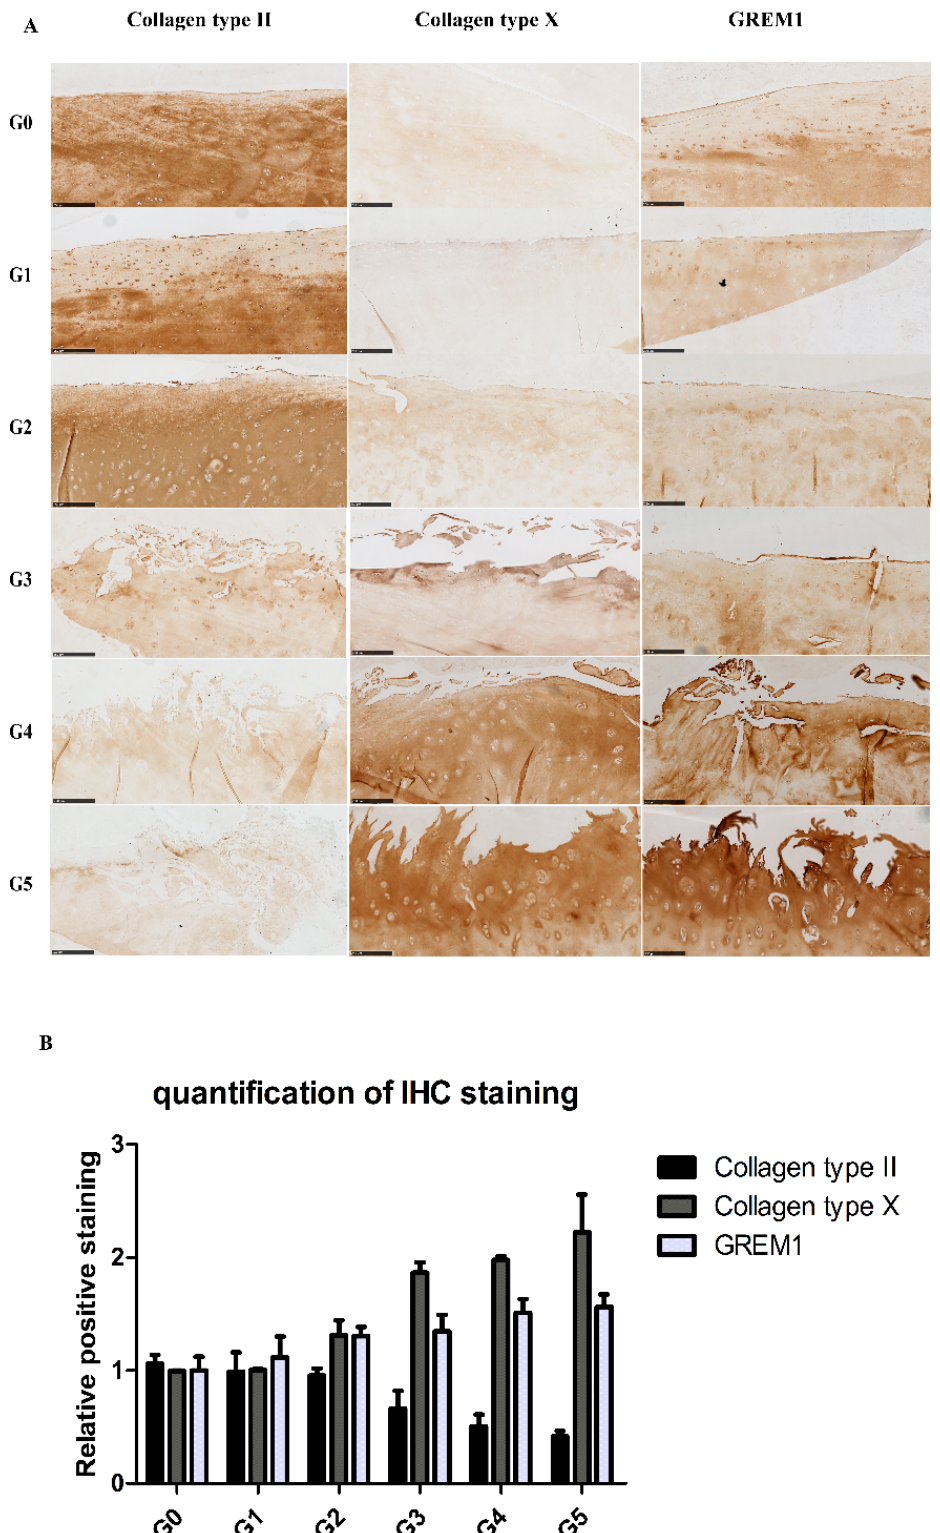
Figure 2. The protein expression of collagen type II, collagen type X and GREM1 was visualized by IHC (scale bar 250 µm). ( A ) Representative pictures are shown. Images were taken using the Nanozoomer. G0, G1, G2, G3, G4, G5 = Grade 0, Grade 1, Grade 2, Grade 3, Grade 4, Grade 5; ( B ) Quantification of positive staining was performed by ImageJ software (Wayne Rasband, Bethesda, MD, USA).